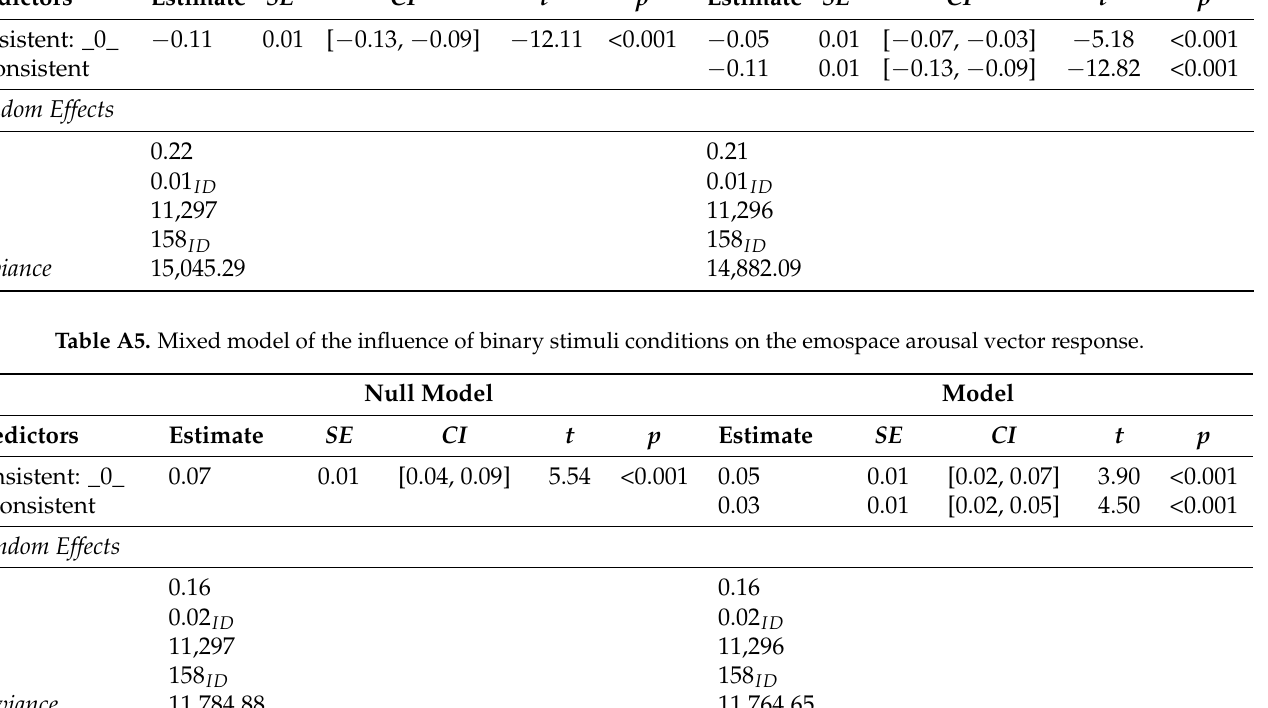
Table A4. Mixed model of the influence of binary stimuli conditions on the emospace valence vector response. Null Model Model